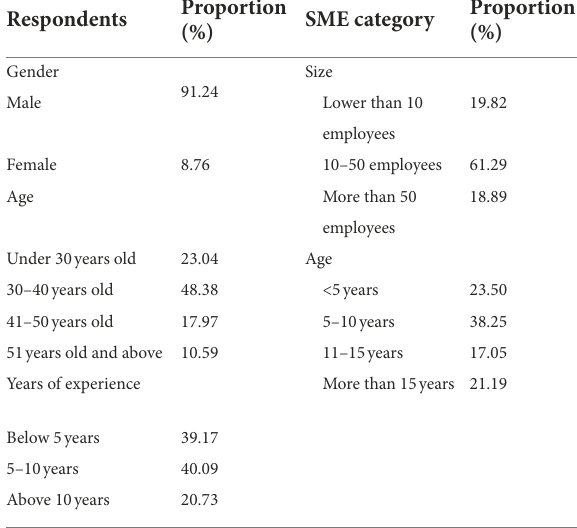
TABLE 1 The demographic characteristics of the sample ( n =